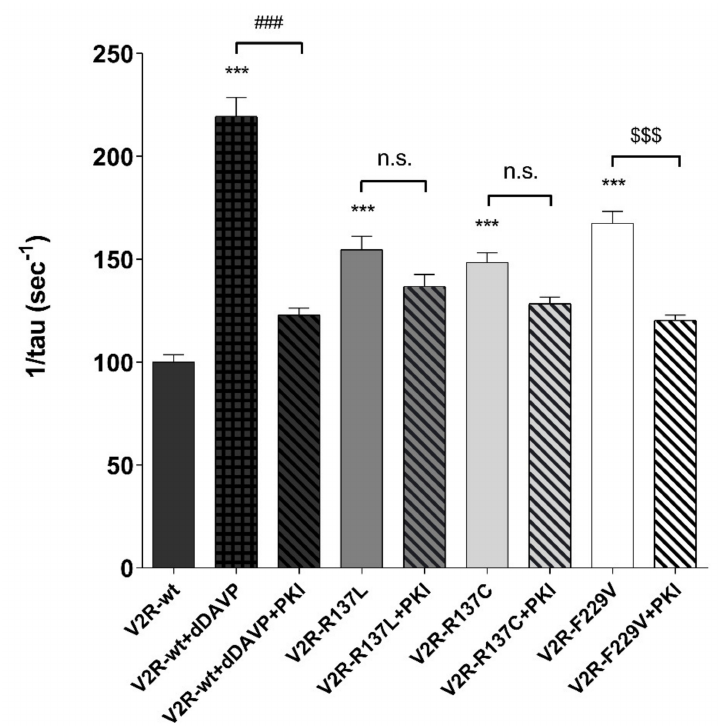
Figure 2. E ff ect of the PKA inhibitor, PKI, on osmotic water permeability in MCD4 cells expressing wild type and mutated V2R. The temporal osmotic response is indicated as 1 / tau (expressed in sec − 1 ). In cells expressing the wild-type V2R, PKA inhibitor, PKI (10 µ M for 30 min), prevented the increase in the osmotic water permeability in response to desmopressin (dDAVP, 100 nM for 45 min). In cells expressing the active mutants, the PKA inhibitor, PKI (10 µ M for 30 min), significantly reduced the basal osmotic water permeability only in F229V expressing cells. The data, expressed as a percentage of the values measured in the cell expressing the wild-type V2R, are means ( ± S.E.M.) of 5 experiments (*** p < 0.001 vs. V2R-wt; ### p < 0.001 vs. V2R-wt + dDAVP; $$$ p < 0.001 vs. V2R-F229V; n.s.: not significant vs V2R-R137L or